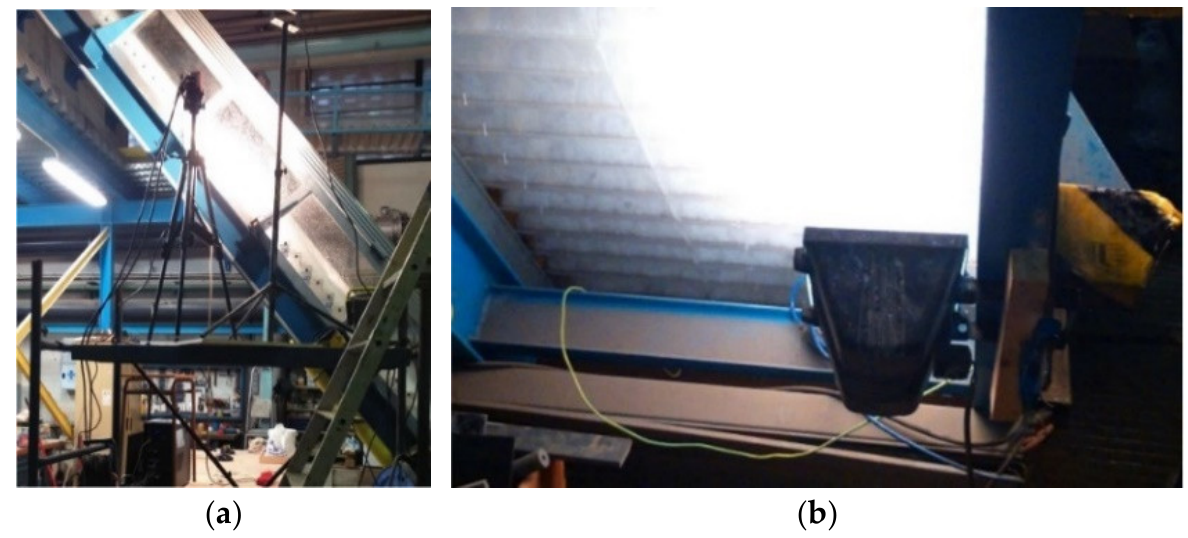
Figure 3. ( a ) Image collection apparatus for L / L t = 0.49 (which is equivalent to that on L / L t = 0.88 ) using frontal illumination. ( b ) Image collection apparatus for L / L t ranging from 0.88 to 0.89 using back illumination.